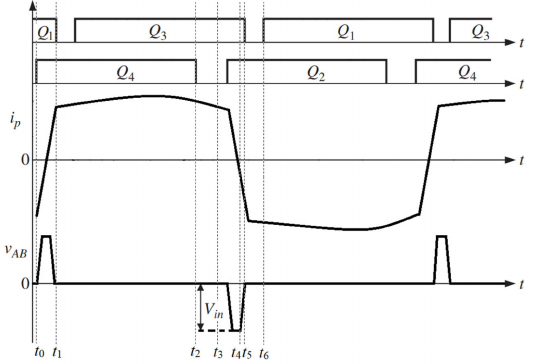
Figure 8. Waveforms of MOSFETs control signals V AB , and i p for the proposed soft-switching